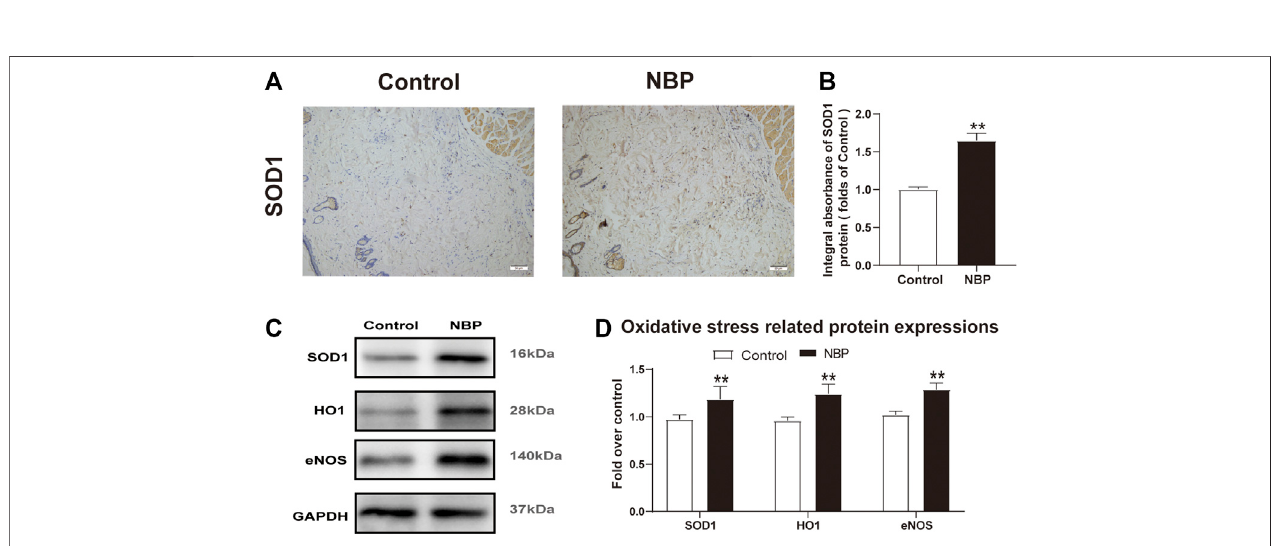
FIGURE 4 | NBP attenuates oxidative stress in multiterritory perforator fl ap. (A) IHC of SOD1 in each group (200X); scale bar, 50 μ m. (B) Optical density values of SOD1 in each group. (C) Western blotting for SOD1, HO1, and eNOS in each group. (D) Optical density values of SOD1, HO1, and eNOS in each group. Gels were run undersimilarexperimental conditionsand croppededitedonly for clarity.Valuesareshown asmean ± SEM, n (cid:1) 6 per group. * p < 0.05and ** p < 0.01 vs. controlgroup.